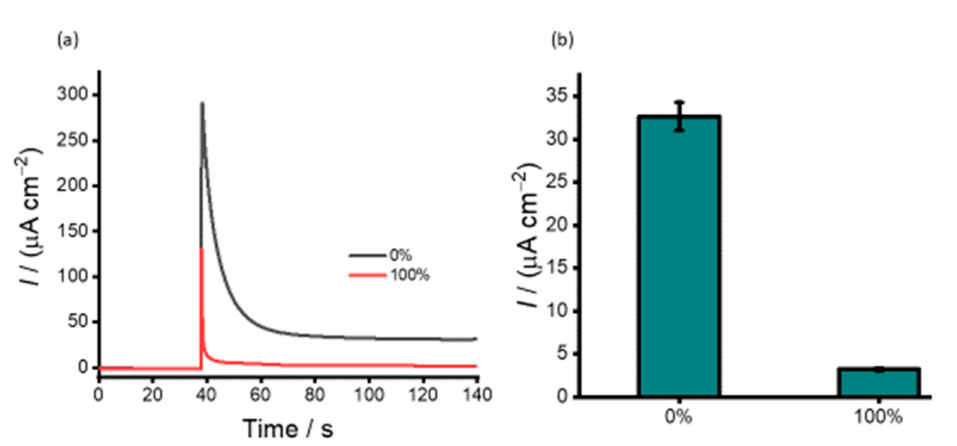
Figure 2. ( a ) Amperometric current density responses with respect to the presence (red) and absence (control) of 100% methylated synthetic sequences. ( b ) Corresponding current density profiles for the 100% target (right bar) and control (left bar) samples. Error bars represent the standard deviation of three repeat